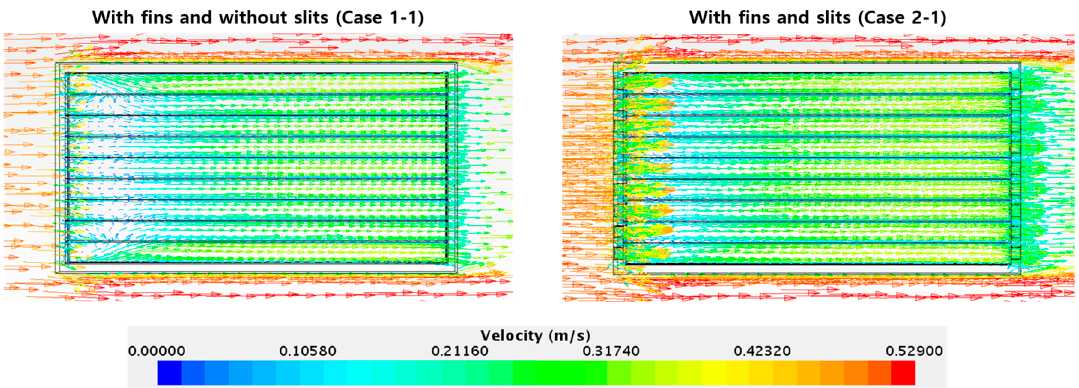
Figure 8. Velocity distribution of the cases with